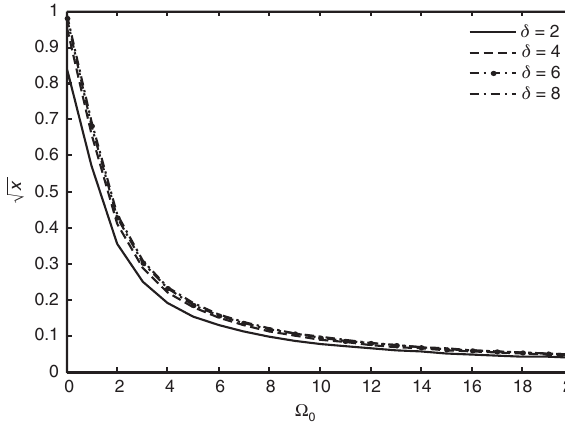
Figure 10: Variations of non-dimensional phase speed ( ) x against impedance parameter δ